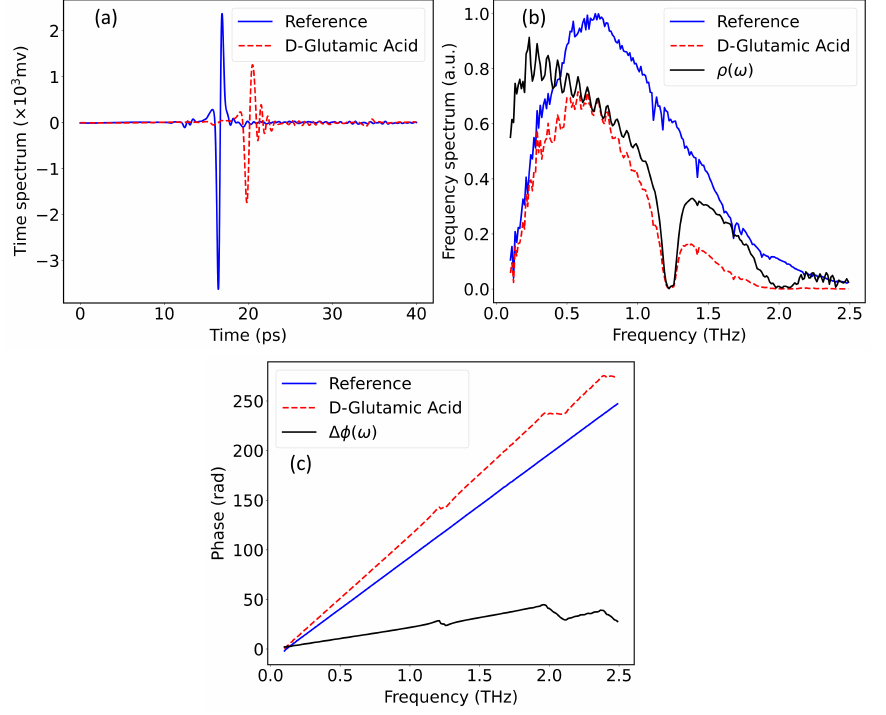
Figure 2. A comparison between the reference signal and the D-Gluatamic acid regarding ( a ) the time-domain spectra, ( b ) the amplitudes of the frequency–domain spectra, ( c ) the phases of the frequency–domain spectra. The solid black curves in ( b , c ) denote the amplitude and the phase of the transfer function,